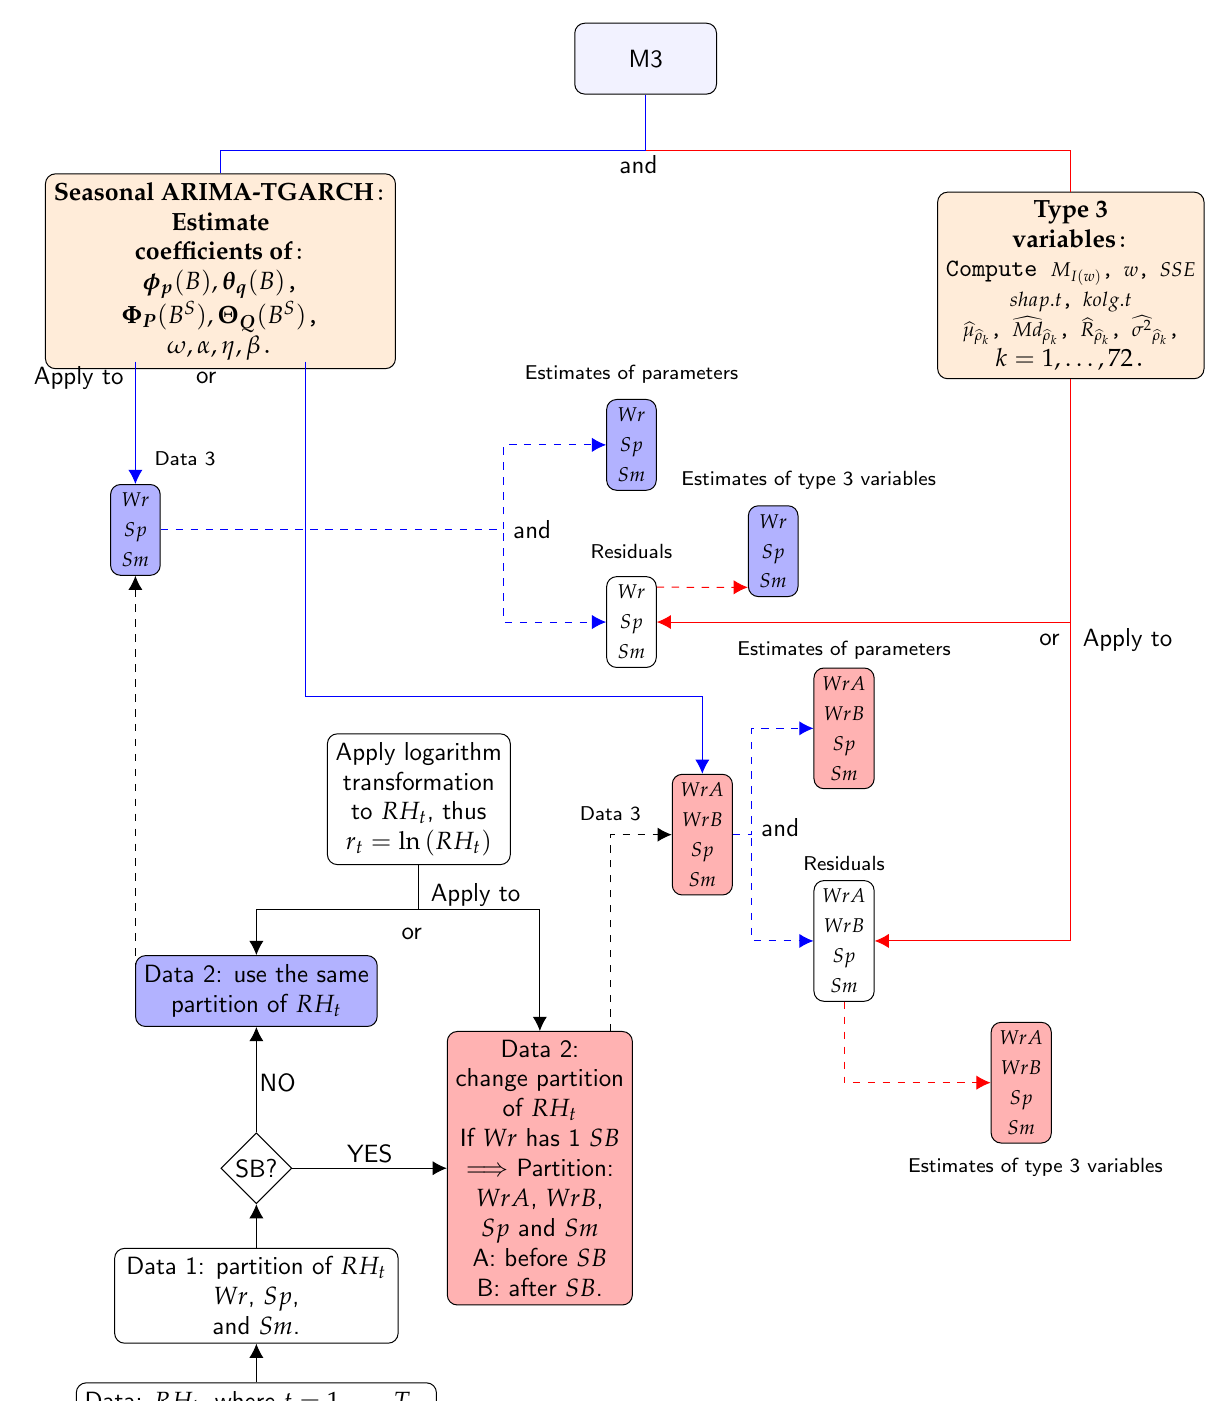
Figure 6. Flow chart for the steps of method 3: Blue lines indicate estimated parameters. Red lines indicate type 3 variables. Solid lines indicate processes. Dashed lines indicate results. The first step divides the different time series according to the climatic conditions (Wr, Sp, and Sm) (Data 1). The second step organises the time series according to possible structural breaks (SBs) (Data 2). The third step applies logarithmic transformation to Data 2, the result is Data . The fourth step applies the model to Data 3 in order to obtain the estimates of model parameters (first result) and then the residuals from the method. The fifth step consists of applying the formulas of type 3 variables to the residuals (second result). Different boxes display symbols Wr, Sp, and Sm (or WrA, WrB, Sp, and Sm). This indicates that the results correspond to all different parts of the time